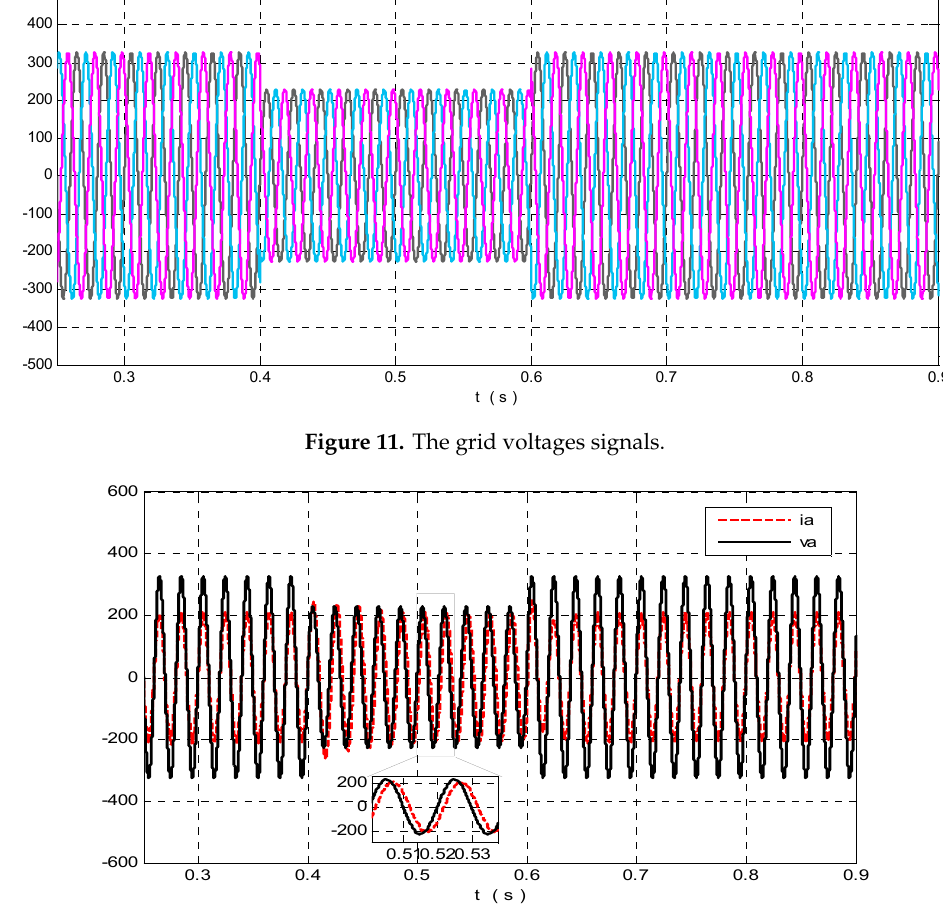
Figure 12. Voltage and current signals (phase a).